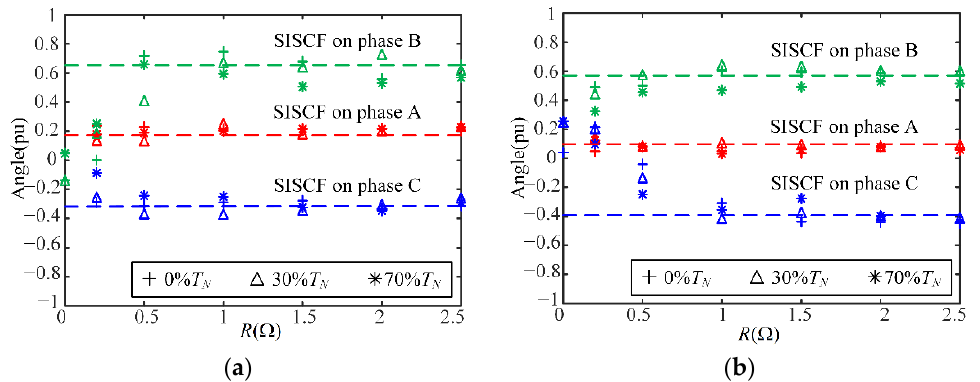
Figure 11. Park vector trajectory ellipse long axis tilt angle of simulation data: ( a ) The motor operates at 10 Hz. ( b ) The motor operates at 30